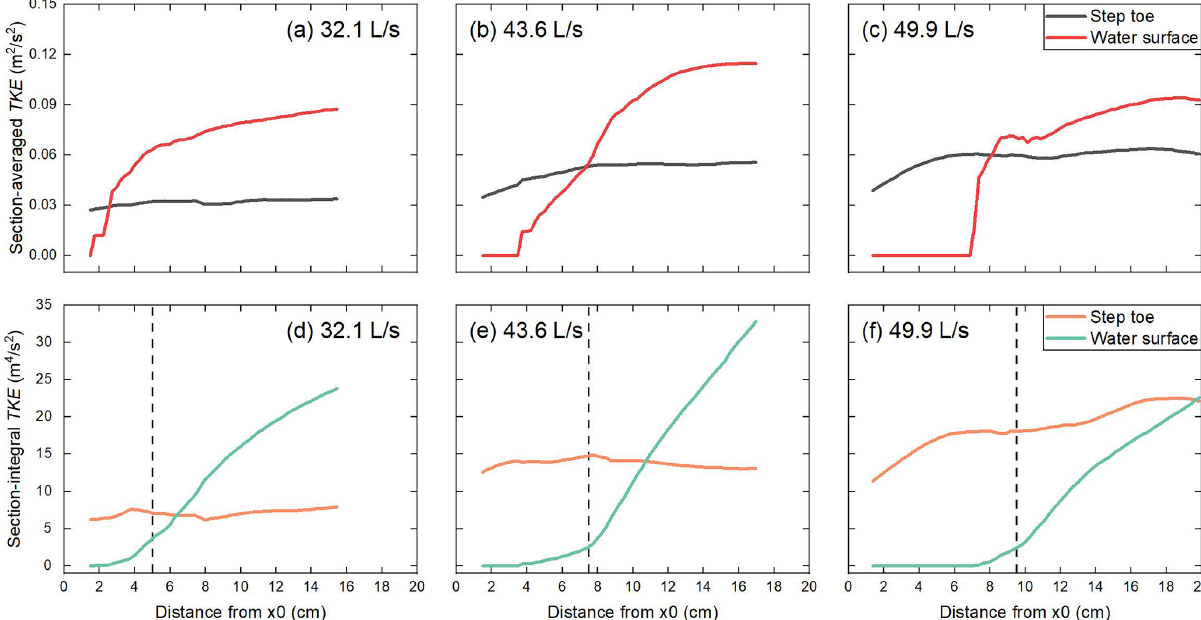
Figure 12. Longitudinal distributions of section-averaged and section-integral turbulent kinetic energy (TKE) for the flow recirculation cells at the step toe, near the water surface, and at the largest three discharges. The flow direction is from left to right in all the plots. The general locations of the contraction sections under the three flow rates are marked by dashed lines in (d) to (f)